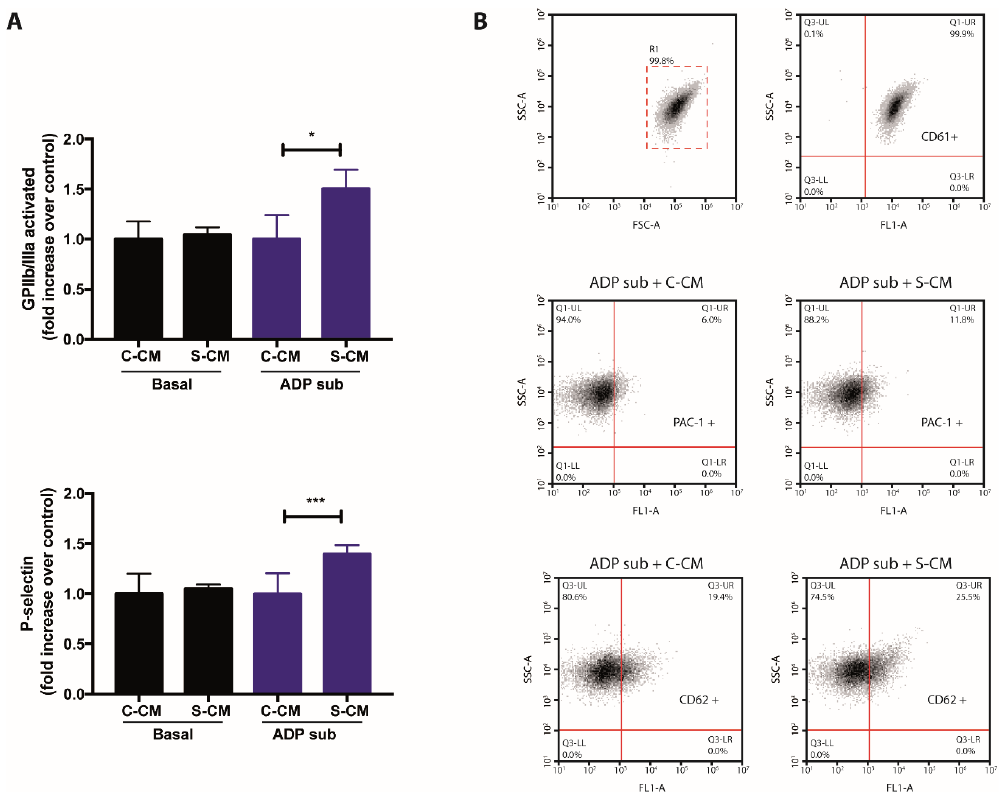
Figure 4. Effects of media conditioned by senescent cells on platelet activation. ( A ) The presence of activated GPIIb/IIIa and P-selectin on the surface of platelets, previously exposed to media conditioned by senescent and non-senescent HMEC-1 cells, was determined by flow cytometric analyses. Platelets under basal and sub-aggregating (ADP sub) conditions were tested. ( B ) Representative dot plots for the detection of CD61 (platelets; top), PAC-1 (activated GPIIb/IIIa; middle) and CD62 (P-selectin; bottom) on human platelets. ADP sub: 1.3–2.0 μM ADP; C-CM: Control conditioned medium; S-CM: Senescent conditioned medium; SSC: side scatter; FSC: forward scatter. The graph depicts the mean ± SD of n =